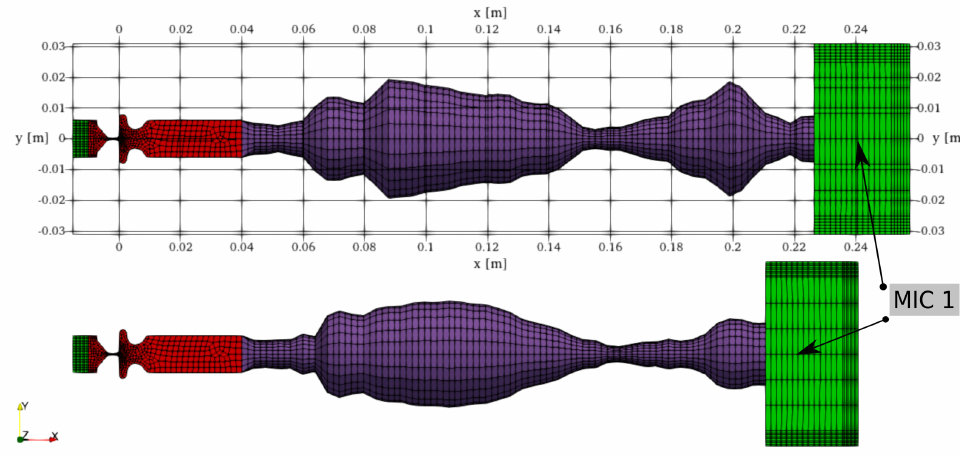
Figure 7. Geometry, mesh and probe location for computational aeroacoustic (CAA) simulations— vocal tracts [u:] ( top ) and [i:] ( bottom ). Red—larynx, purple—vocal tract,